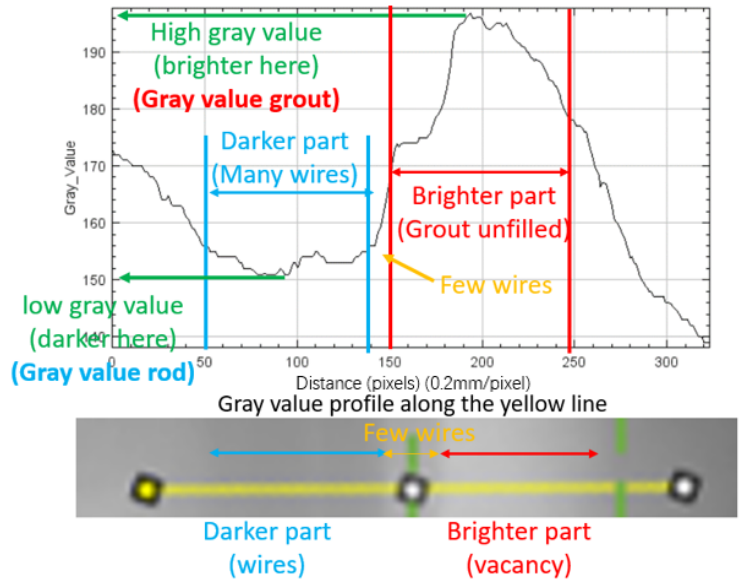
Figure 19. Gray value profile of the line segment in Figure 18.